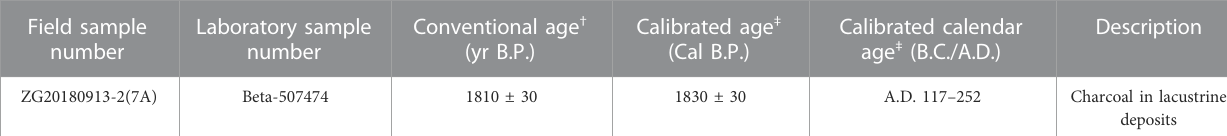
TABLE 1 Radiocarbon analysis of charcoal in lacustrine deposits. The sample was collected from the Camel City site (see Figure 7 for